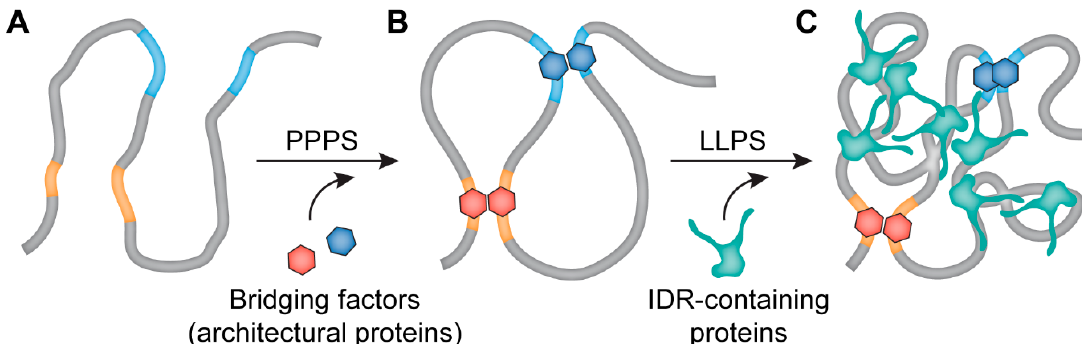
Figure 2. A putative two-step process of the chromatin droplet formation. At the first step, architectural proteins (red and blue hexagons), which can interact with each other, bind to its motifs in the DNA ( A ). This process results in the formation of loops ( B ) and partial condensation of the chromatin chain (polymer-polymer phase separation, PPPS). Next, IDR-containing chromatin-binding proteins establish multiple weak interactions with each other and with other components of chromatin collapsing the chromatin chain into a droplet (liquid-liquid phase separation; C ).